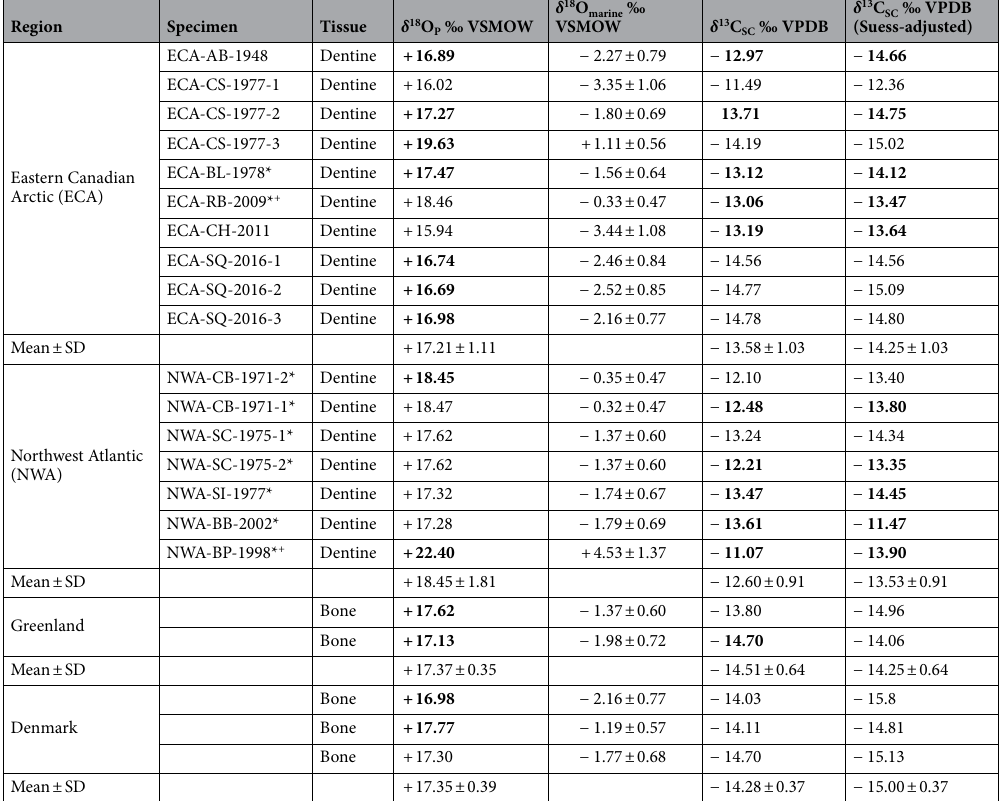
Table 2. ‘Whole-tooth’ dentine δ 18 O P and δ 13 C SC of killer whales that stranded in the eastern Canadian Arctic (ECA) and Northwest Atlantic (NWA), along with values measured in bone of killer whales from Greenland and Denmark. Source marine values ( δ 18 O marine ) were estimated from a published calibration 22 and form the basis of the inferred geographic distributions presented in Fig. 4. Suess-adjusted δ 13 C SC values account for temporal bias due to baseline shifts in North Atlantic δ 13 C (see Figure S2) by adding − 0.023‰ year −1 * (2013— sample year—half the whale’s age) to δ 13 C SC . Values shown in bold are the averages of replicate analyses. *Annual dentine growth layer groups (GLGs) of these whales were also measured for δ 18 O in structural carbonate (see Fig. 5). + These whales have previously identified differences in diet and morphology 51,52